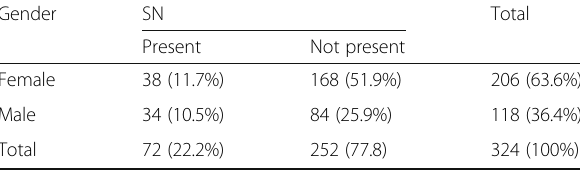
Table 2 Gender of the SN-affected